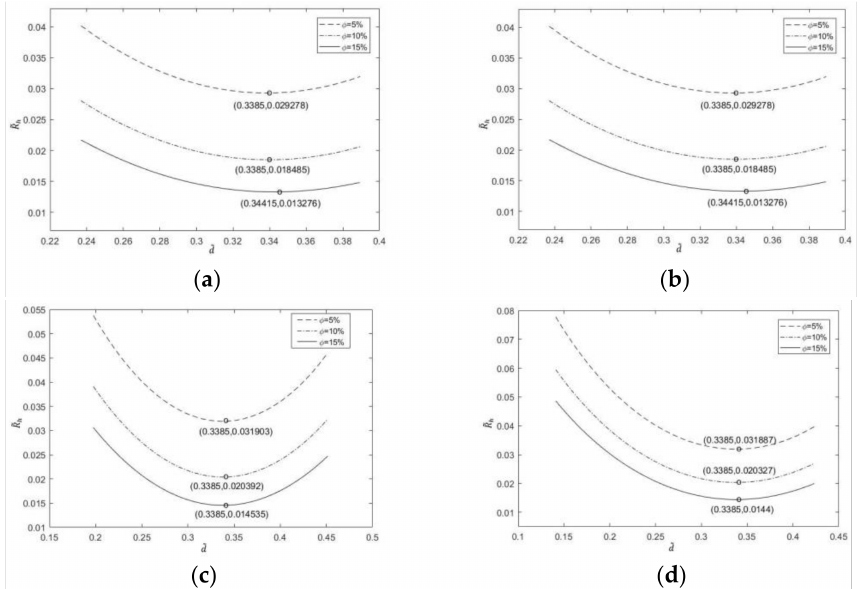
Figure 14. The influence of ϕ on (cid:101) R h in four models at N = 4. Where subfigures ( a – d ) are Model 1, 2, 3 and 4